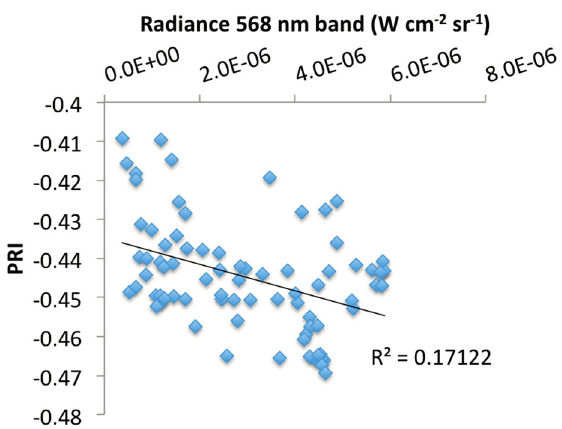
Figure 9. Relationship between upwelling radiance, as measured by the 568 nm band, and light-use efficiency (LUE), as derived using the eddy-covariance technique.